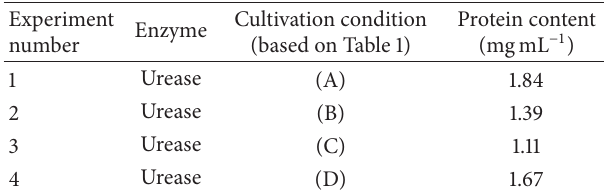
Table2:TheeffectofcultivationmediumonproteincontentofBCN immobilized